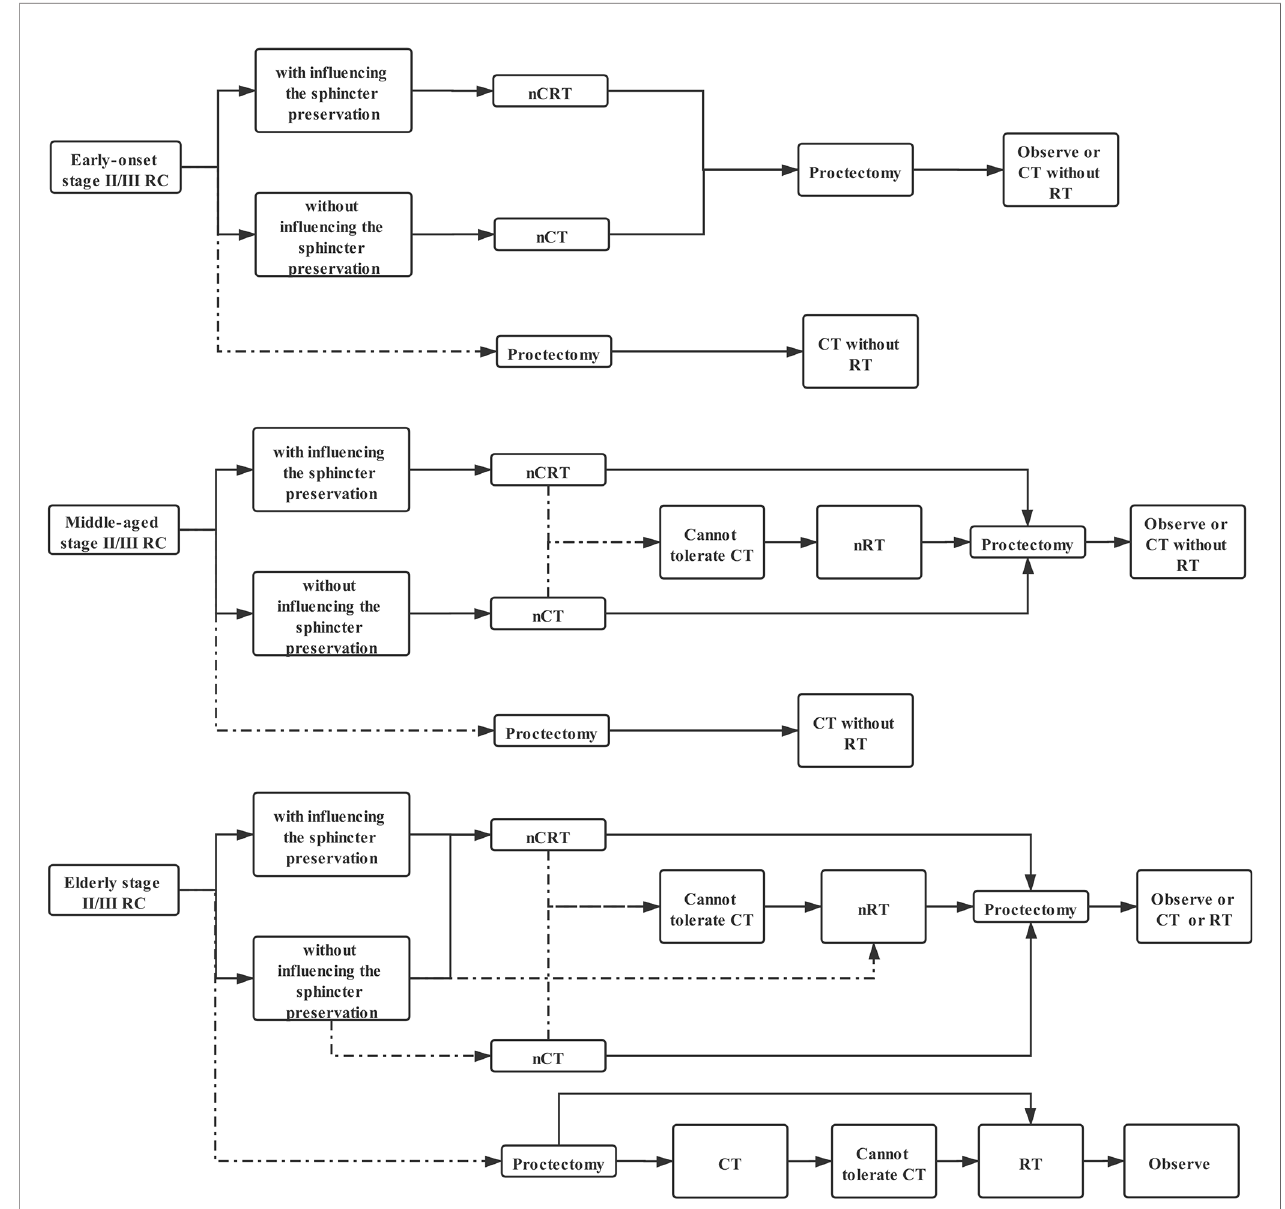
FIGURE 8 | The fl ow chart of radiotherapy decision-making based on age in stage II/III RC patients. (Solid line: preferred option; dotted line: alternative